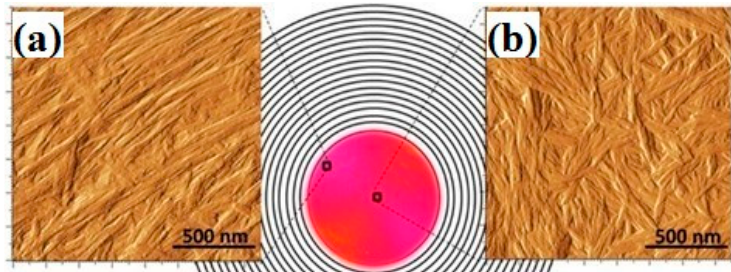
Figure 4. AFM micrographs from the surface of nanocellulose film made by a drying solution casted suspension into a concave glass mold: two scanning areas of 1.5 μ m × 1.5 μ m ( a ) far from center and ( b ) at the center (Reprinted with permission from [59]. Copyright 2013, American Chemical Society.).